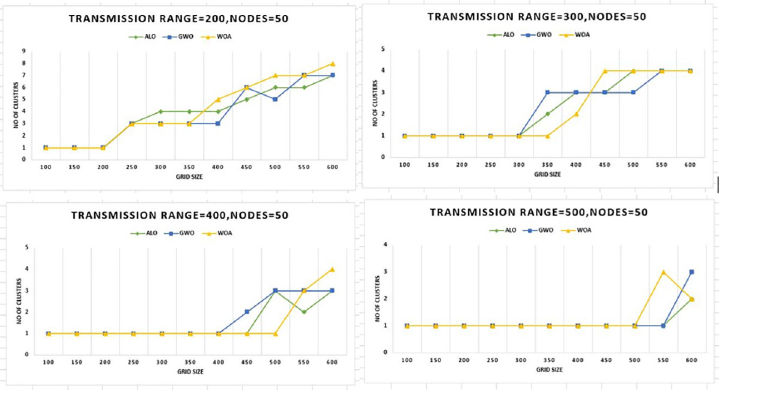
Fig 15. Grid size versus number of clusters for 50